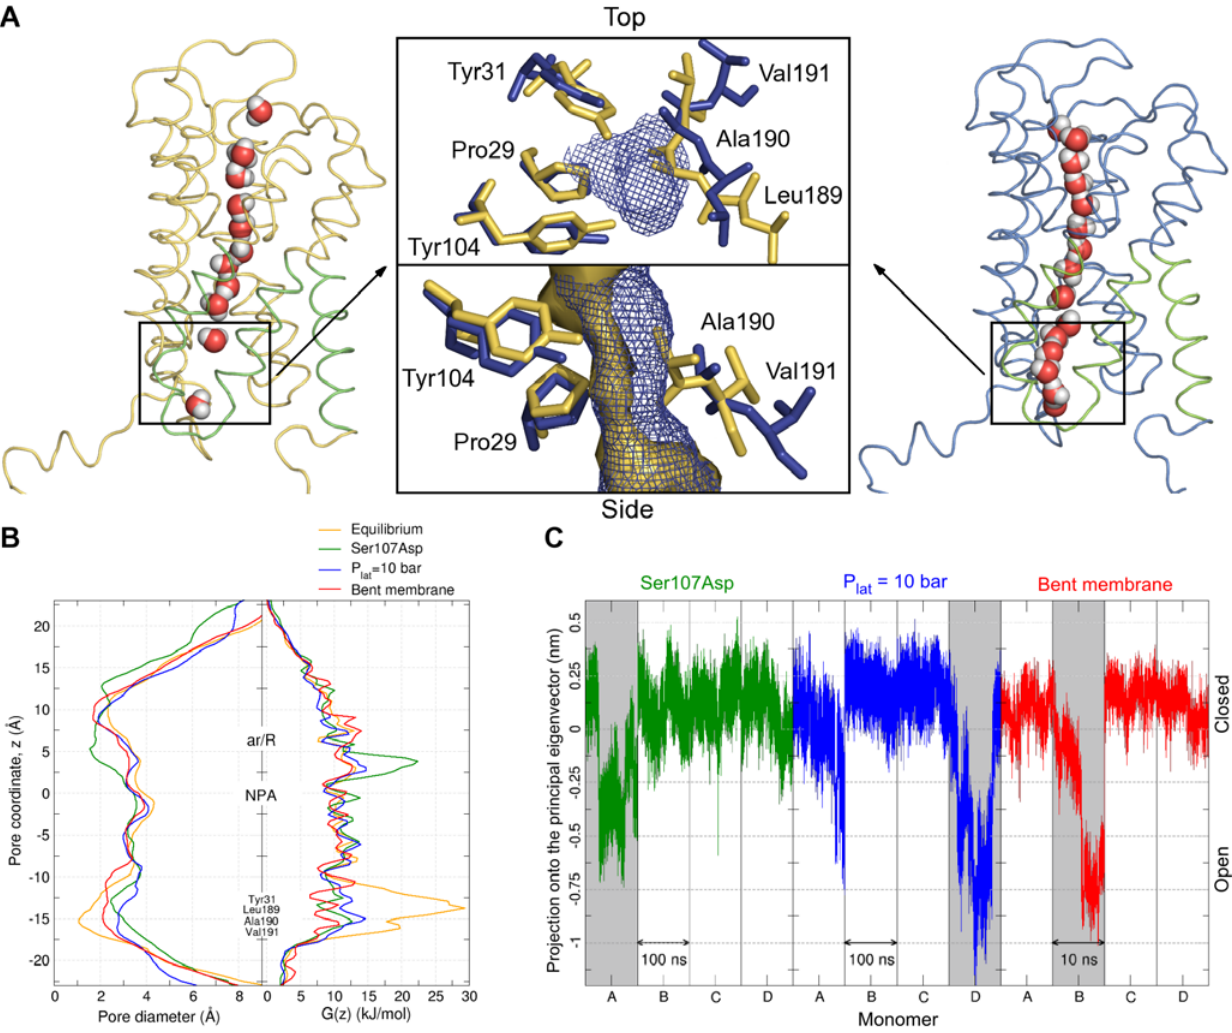
Figure 6. Molecular dynamics simulations of the two putative gating mechanism, phosphorylation and mechanosensitivity. (A) Snapshots of the closed (left) and the open (right) conformations showing how a water column is established in a similar way upon opening, during either simulations of the mutant Aqy1S107D, or increasing the lateral pressure to 10 bar, or bending the membrane towards the cytoplasmic side (the region highlighted in green was considered for the principal component analysis mentioned in the text). Top and side views of the region indicated by the dashed squares are shown in the middle panel: The pore surface is shown for both the closed (yellow) and the open (blue) conformations. The channel widens after a local rearrangement of residues Leu189, Ala190, and Val191, and this motion is observed for all three simulations. (B) Pore diameter profiles (left), showing the widening of the channel near the Tyr31 region for simulations with the mutated Aqy1S107D (green), with an increased lateral pressure (blue), or with a bent membrane (red), compared with the control simulation (yellow). Free energy profiles (right), showing a substantial reduction in the energetic barrier for water permeation in the monomers that opened during the simulations. (C) Projections of nonequilibrium trajectories onto the principal eigenvector obtained by principal component analysis. Transitions are observed upon opening for the monomer A in the left panel (Aqy1S107D), D in the middle panel (P lat =10 bar), and B in the right panel (bent membrane).